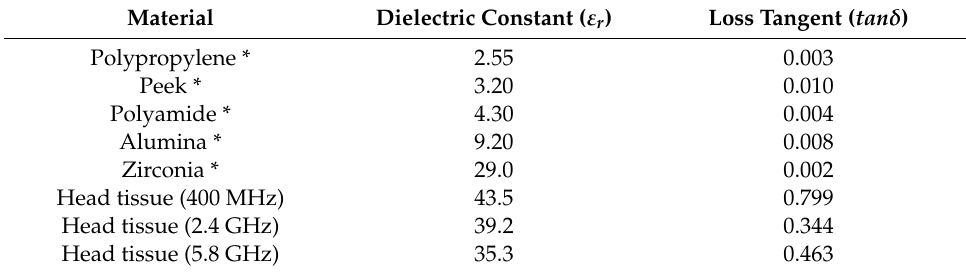
Table 1. Material properties of biocompatible insulators and the homogenous head layer.